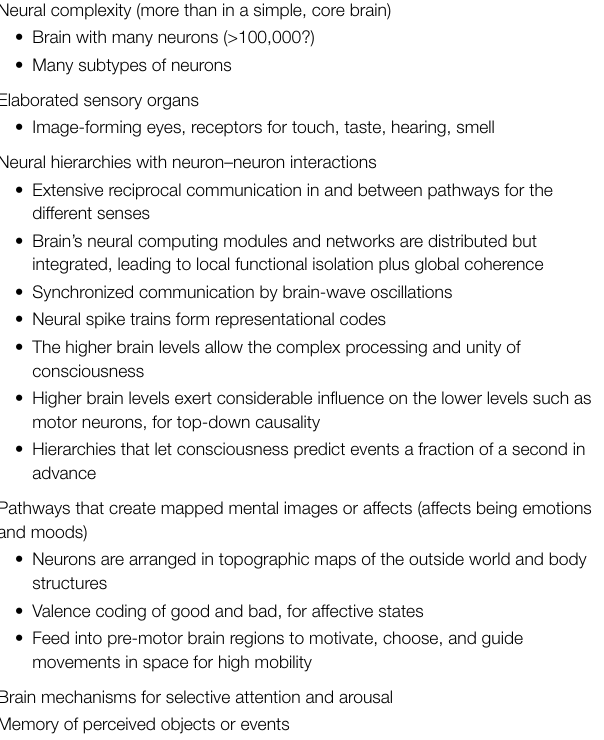
TABLE 1 | The convergently evolved features of consciousness that are shared by vertebrates, arthropods, and cephalopod mollusks (mostly from Feinberg and Mallatt, 2020).